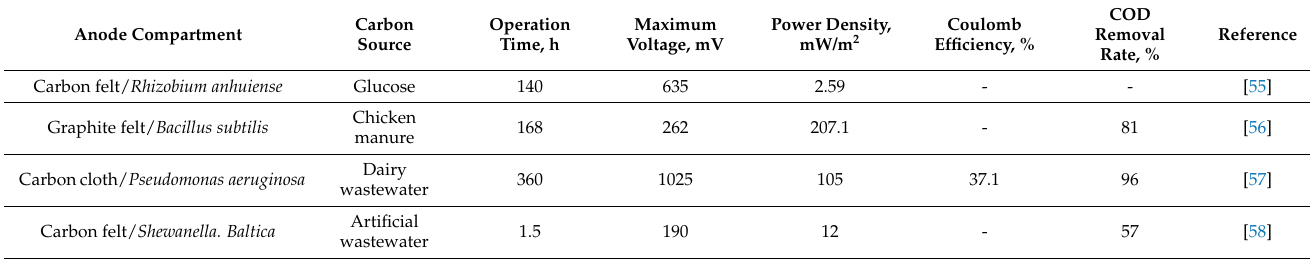
Figure 5. Long-term generation of electric energy by two series-connected MFCs based on PE- DOT:PSS/graphene and during the oxidation of organic substrates contained in synthetic ( A ) and municipal ( B ) wastewater samples. Table 2. Comparison of performances of various MFCs during the treatment of synthetic and real wastewater